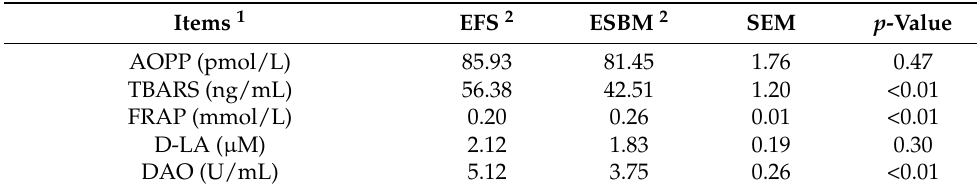
Table 5. Effects of enzyme-treated soybean meal replacing extruded full-fat soybean on serum biochemical indicators in nursery pigs.